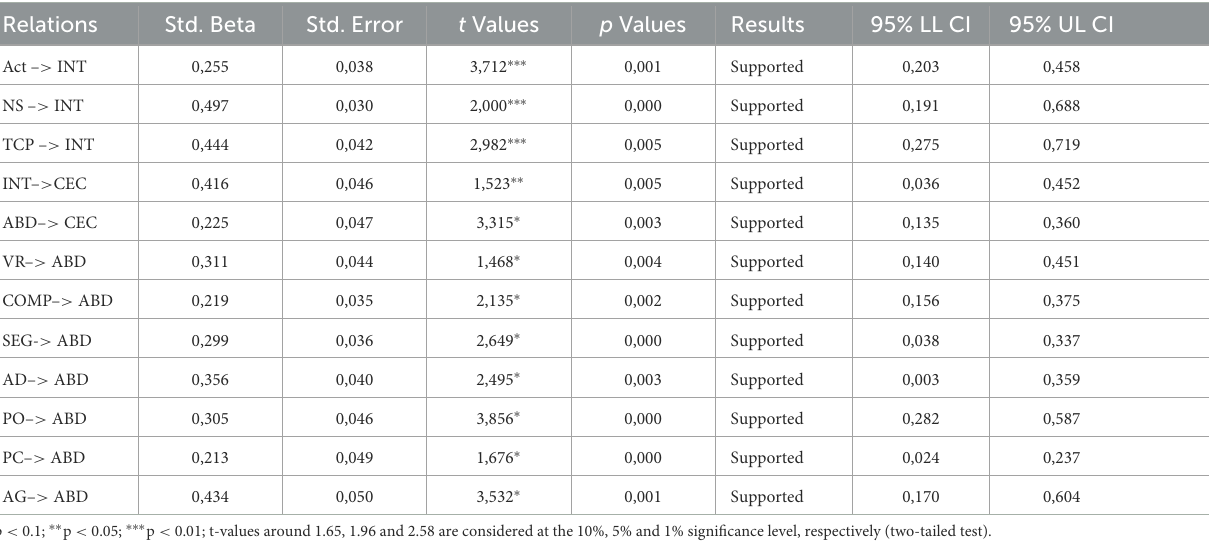
TABLE 5 Hypothesis testing (bootstrapping).